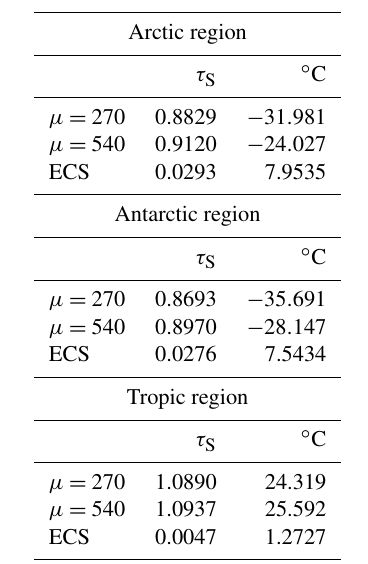
Table 4. ECS values for each of the three regional EBMs. The ECS is much greater for the poles than for the tropics, in agreement with